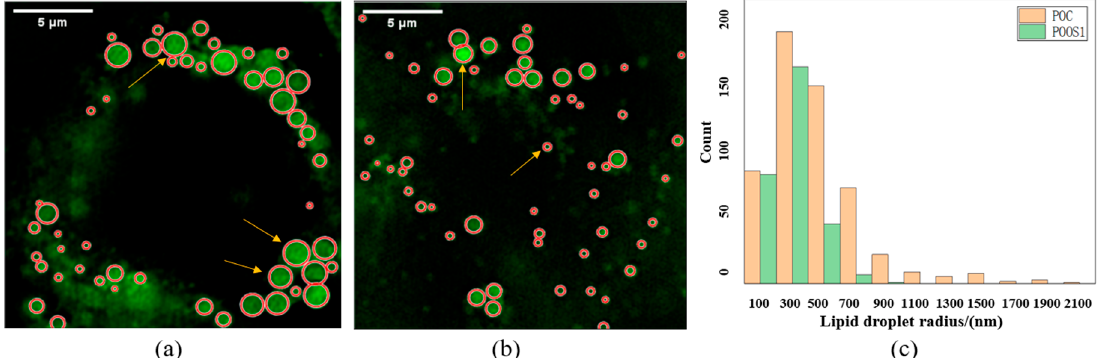
Figure 13. The lipid droplet images of mouse hepatocytes were collected under a 100-fold objective lens and the results were reconstructed with the N-SIM algorithm. ( a ) OSGIN1 gene overexpression cells; ( b ) normal cells; ( c ) the lipid droplets of normal mouse hepatocytes and OSGIN1 gene overex- pression cells were identified and counted. A total of 884 lipid droplets were counted. Yellow column represents normal mouse hepatocytes, and green column represents OSGIN1 gene overexpression mouse hepatocytes. The transverse axis is the radius of lipid droplets, the unit is nanometer, and the longitudinal axis is the number of lipid droplets corresponding to the size.